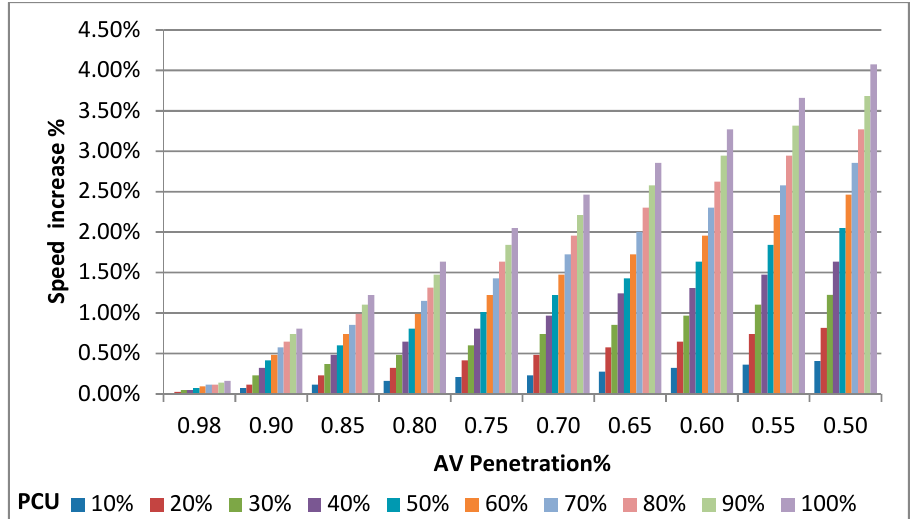
Figure 7. Increase percentage in mean network’s speed for different AV penetration and PCU.